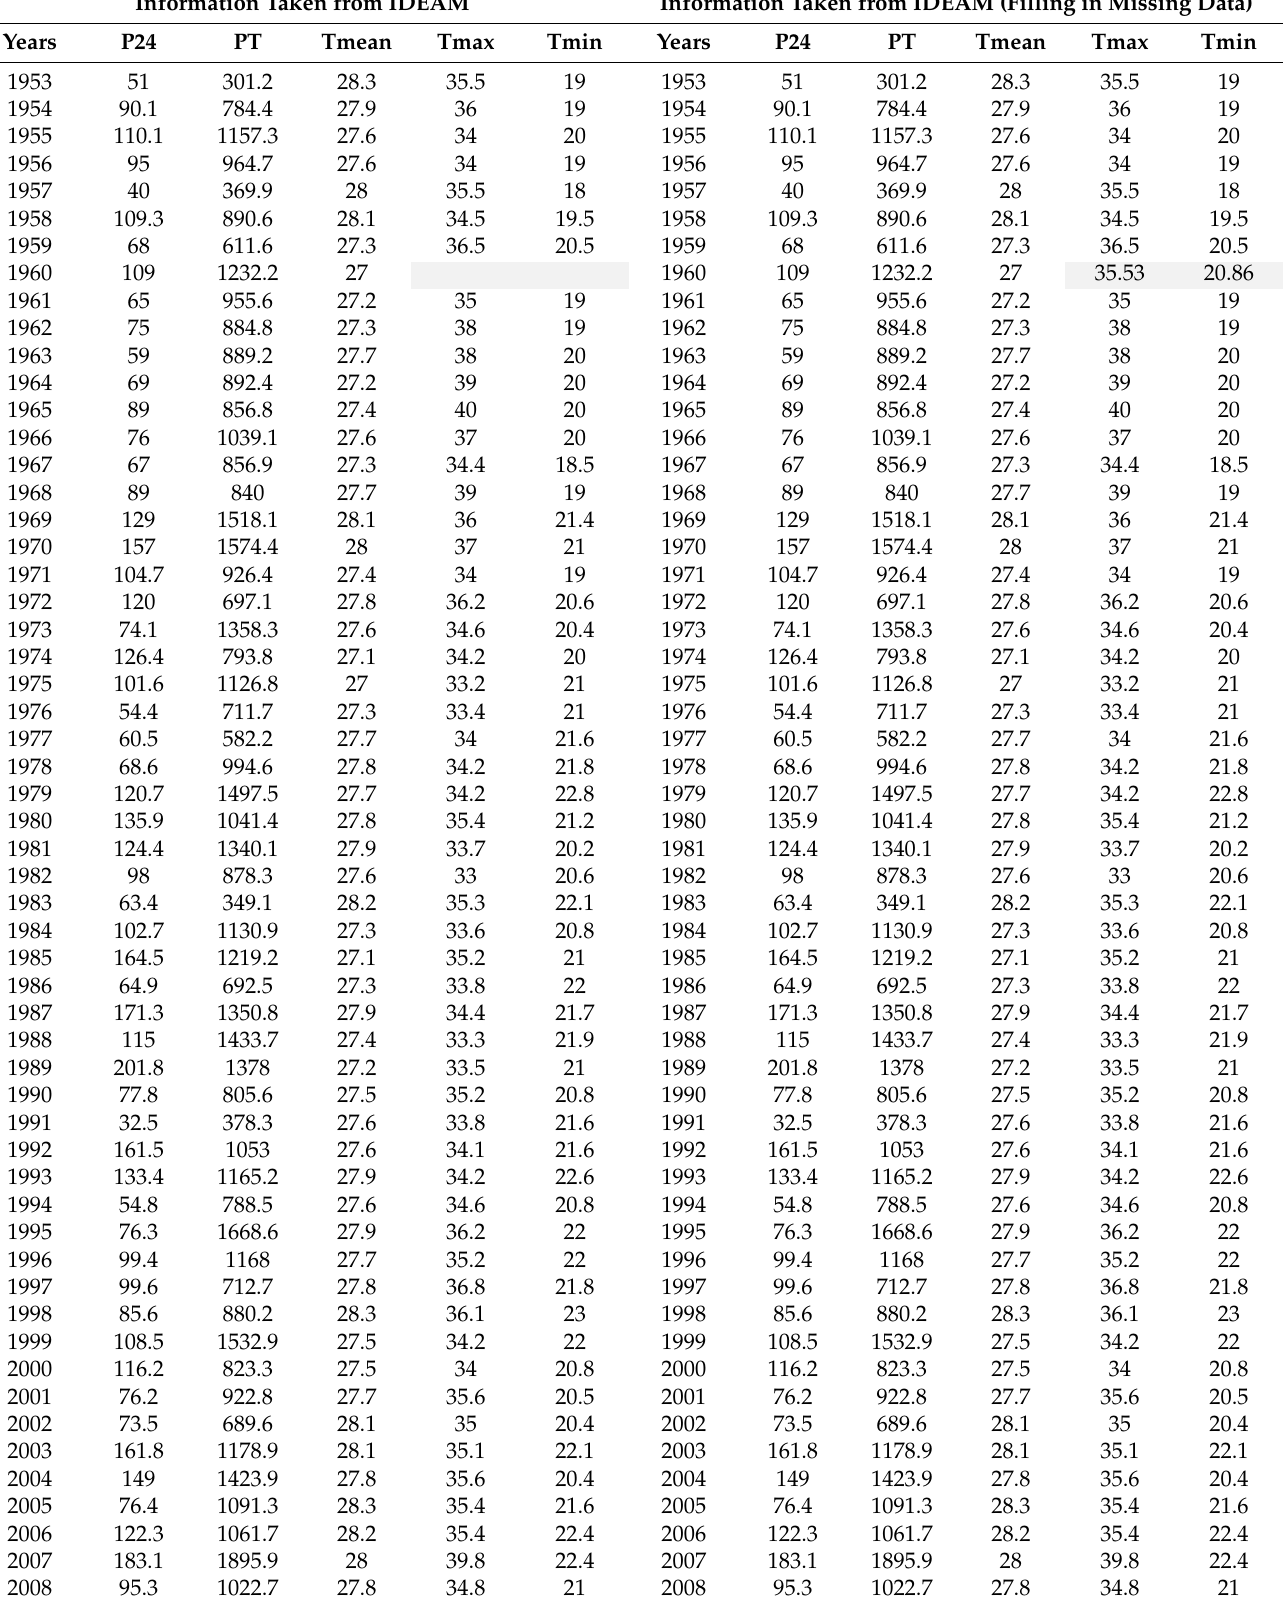
Table A1. Cont. Information Taken from IDEAM Information Taken from IDEAM (Filling in Missing